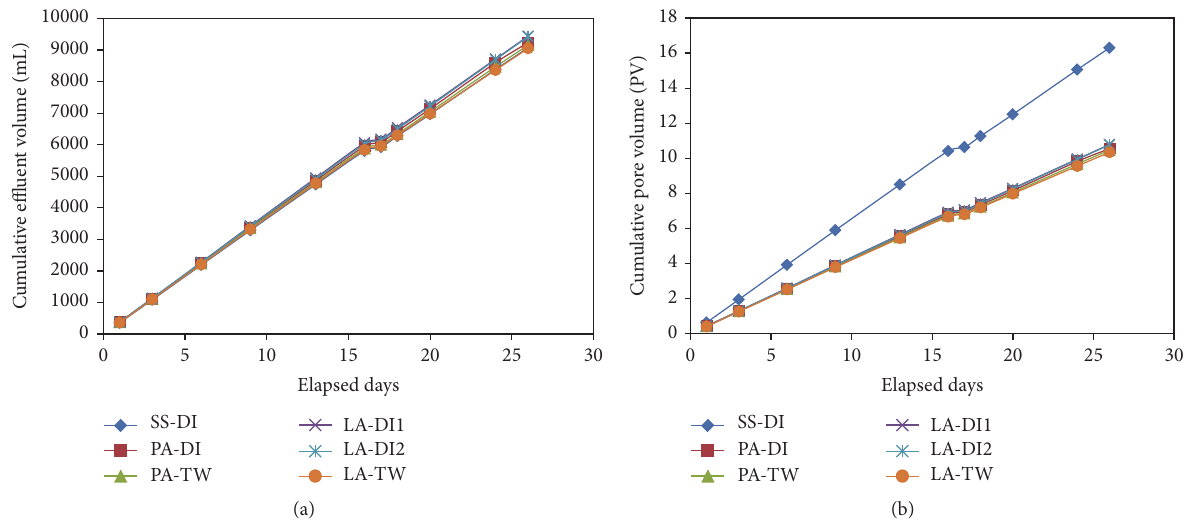
Figure 2: (a) Cumulative effluent volume (mL) and (b) cumulative pore volume (PV) for each column.